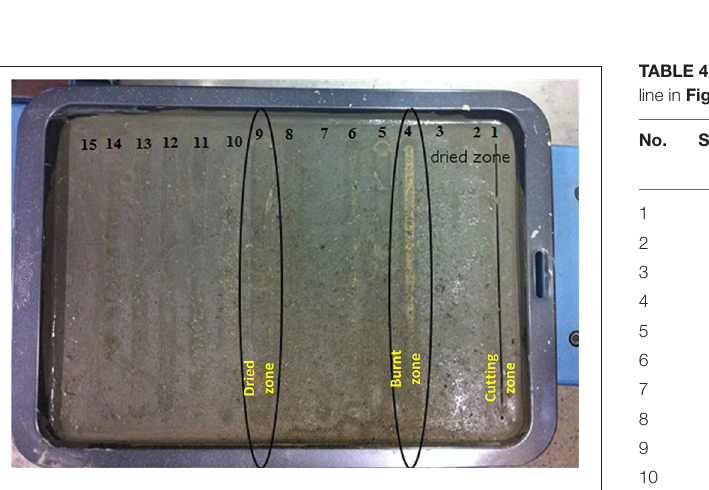
FIGURE 7 | Using laser sintering (SLS) for cement paste using different powers (Watts).